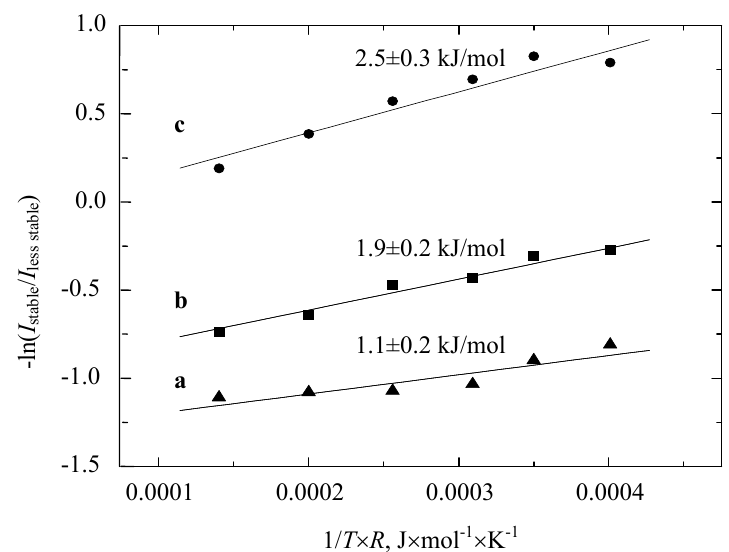
Figure 7. Van’t Hoff plots for 1-butene SOZ conformers in N2 matrix for the band pairs: (a) – 1024 cm -1 (I conformer) and 980 cm -1 (II conformer); (b) - 1024 cm -1 and 967 cm -1 (IV conformer); (c) - 1024 cm -1 and 1011 cm -1 (V conformer).